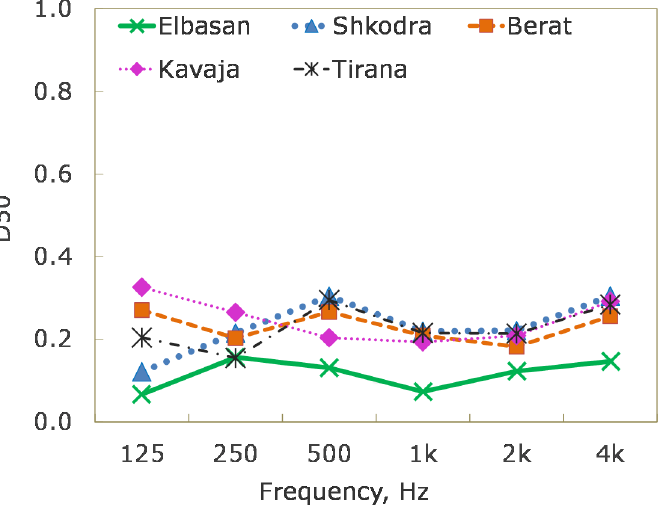
Figure 19. Measured results of definition (D 50 ).